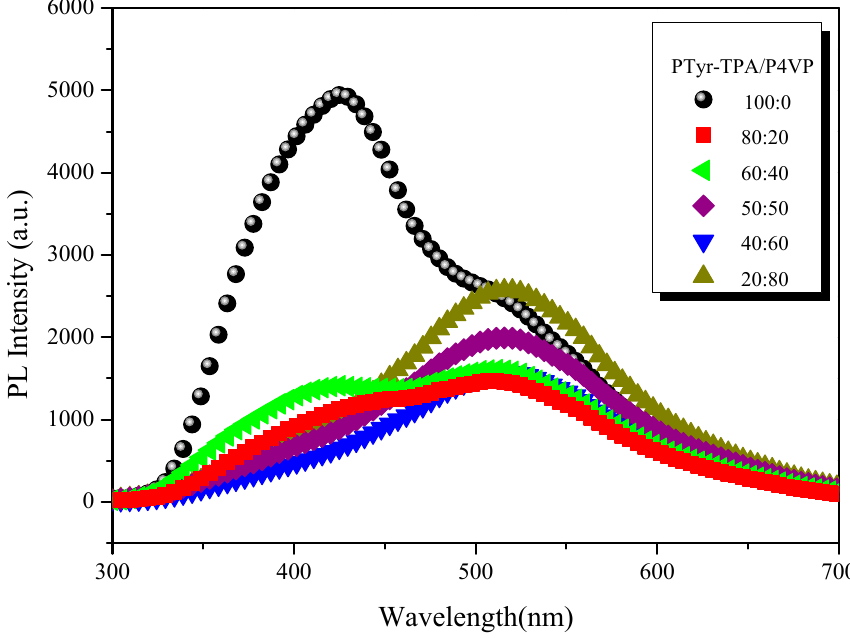
Figure 13. PL spectra (excitation wavelength: 330 nm) of PTyr-TPA/P4VP blends in the solid state.